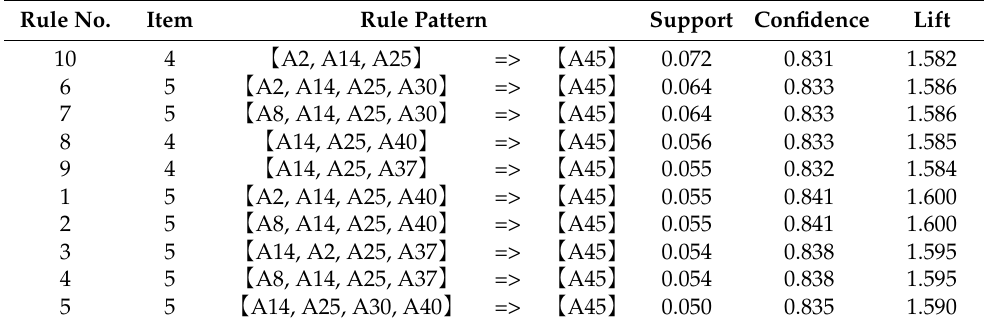
Table 5. Top 10 high-confidence association rules by support for healthcare needs (A45: provide medical allowance).